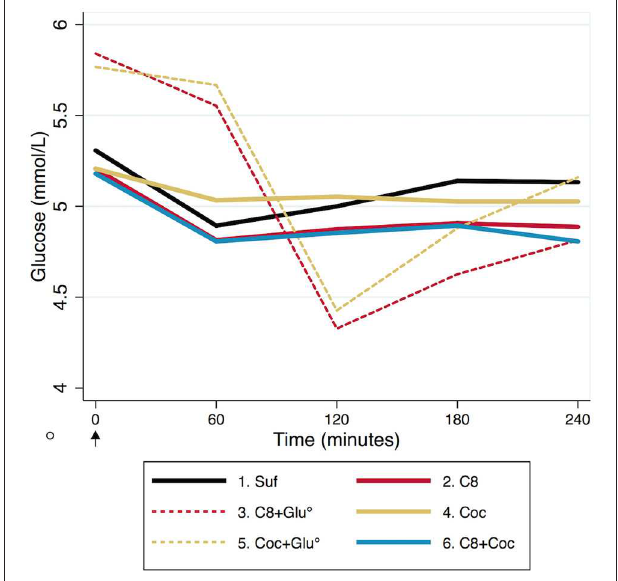
FIGURE 5 | Descriptive dynamics of mean blood glucose during T0–T240 (minutes). T0 represent 12h fasting values, except for arm 3 & 5 (striped), where glucose was ingested 15min before the blood test performed immediately before T0, indicated by a circle. The arrow at T0 indicates the